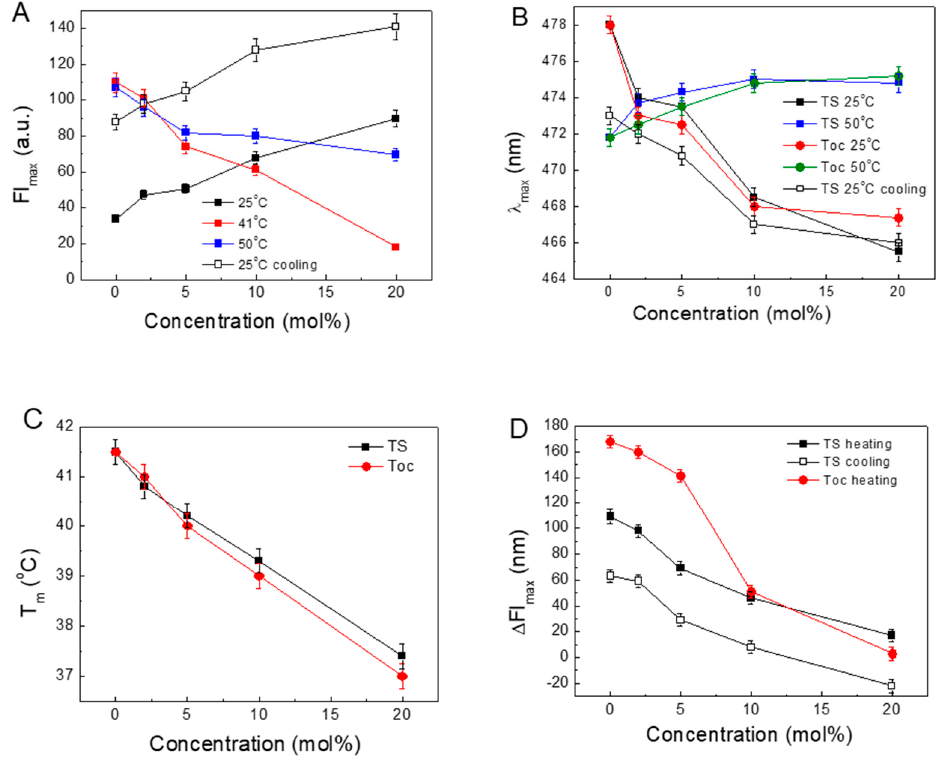
Figure 4. Changes in the ANS parameters observed during the heating/cooling of DPPC with embedded TS or Toc. The TS fluorescence maximum intensities (FI max ) at 25, 41 and 50 °C ( A ). Positions of the fluorescence maxima ( λ max ) with an error of ± 0.5 nm, at 25 and 50 °C ( B ). Shifts in the temperature at the fluorescence maximum (T m ) with increasing concentrations of TS and Toc ( C ). Decreasing amplitude of ANS intensity ( Δ FI max ) ( D ). Δ T = 0.25 °C.